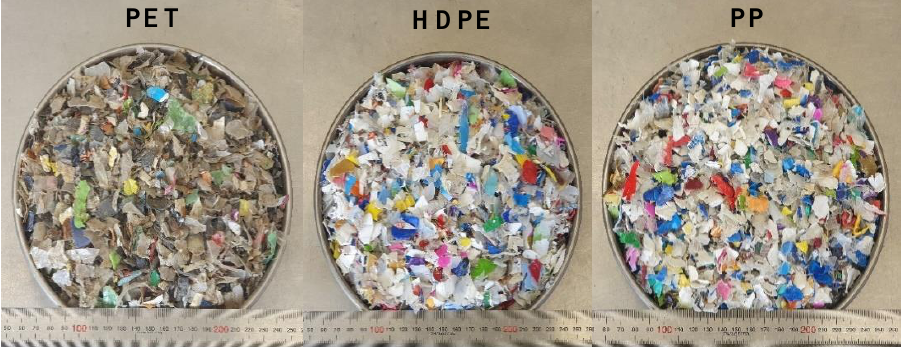
Figure 1. Three types of plastic shredded plastic waste aggregates.